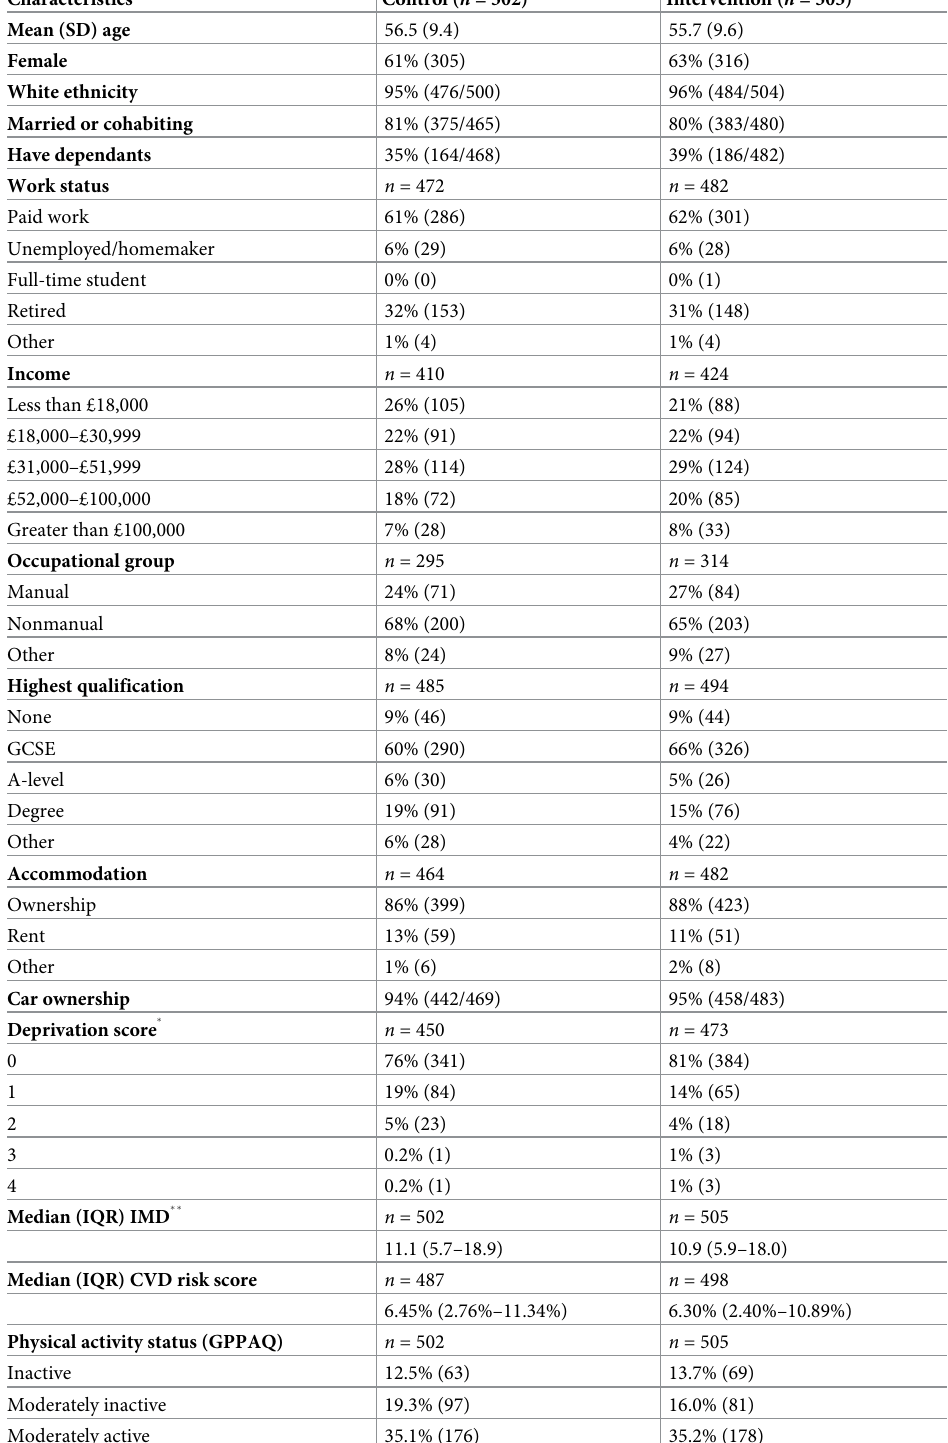
Table 1. Baseline characteristics of participants allocated to intervention and control groups. Values are percent- ages (numbers) unless otherwise